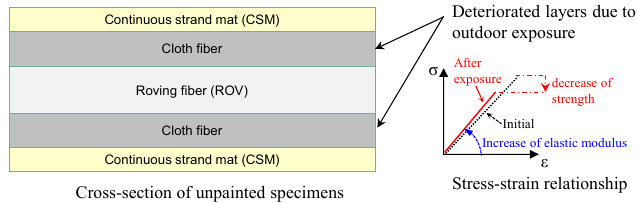
Figure 5. Summary of results of unpainted specimens.